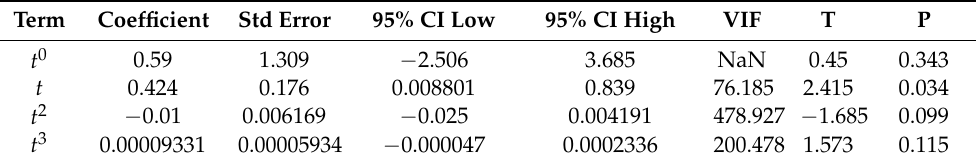
Table 4. Results of statistical analysis, for the interpolation (using third-degree polynomial) of lettuce diameter crowns variation over time, grown in soil with 4.5% zinc concentration.